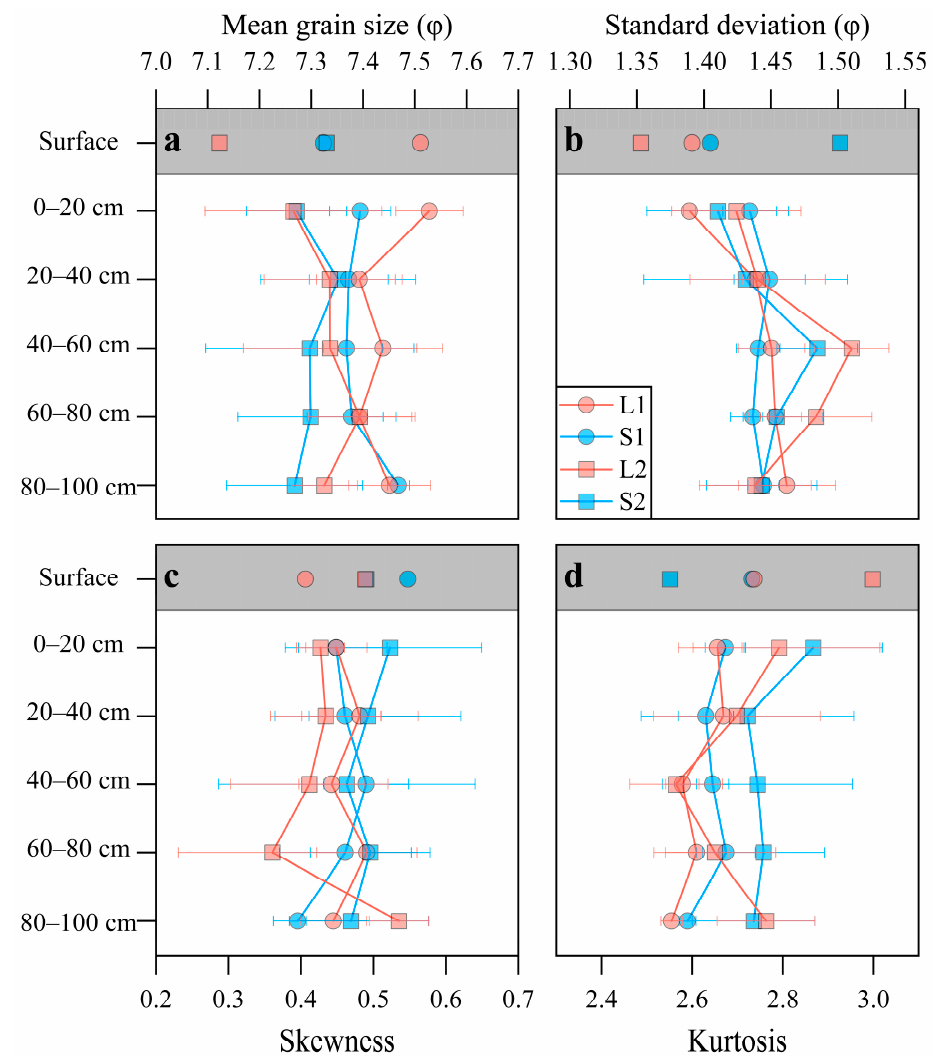
Figure 3. Vertical profile of different parameters ( a ) mean grain size, ( b ) standard deviation, ( c ) skewness and ( d ) kurtosis along the sediment cores. Gray area represents surface sediments at depth of 0–2 cm. Each segment data is presented as mean ± standard deviation. Error bar indicates standard deviation.